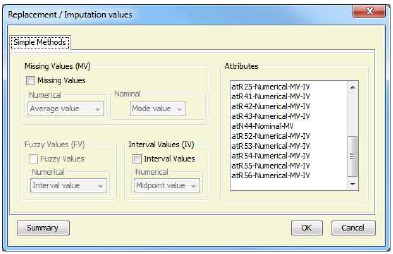
Fig. 8. Replacement/imputation of